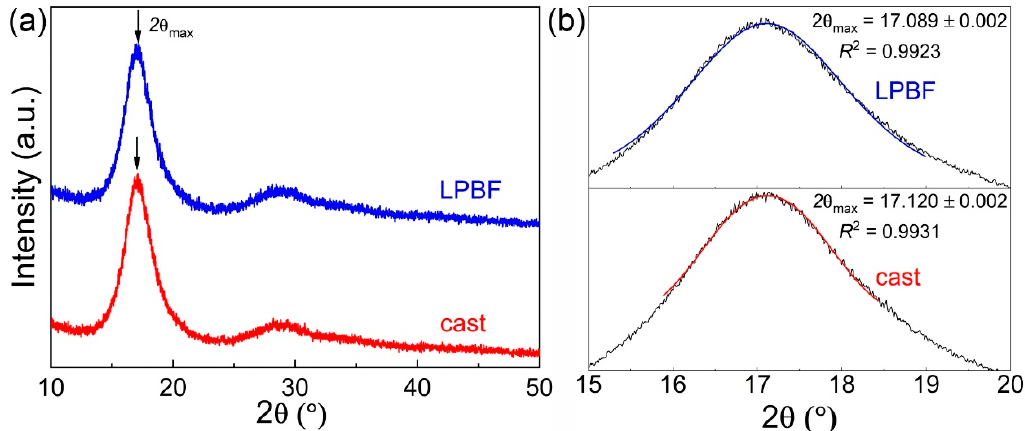
Figure 2. ( a ) Representative XRD patterns for the Zr 52.5 Ti 5 Cu 18 Ni 14.5 Al 10 BMGs fabricated by casting and LPBF exhibiting the broad diffraction peaks characteristic of amorphous materials. ( b ) Position of the main scattering peak (2 θ max ) evaluated by fitting using a Pseudo-Voight